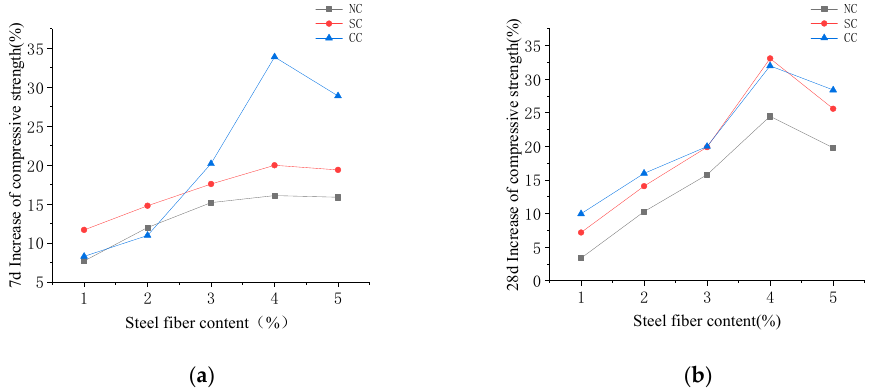
compressive strength.